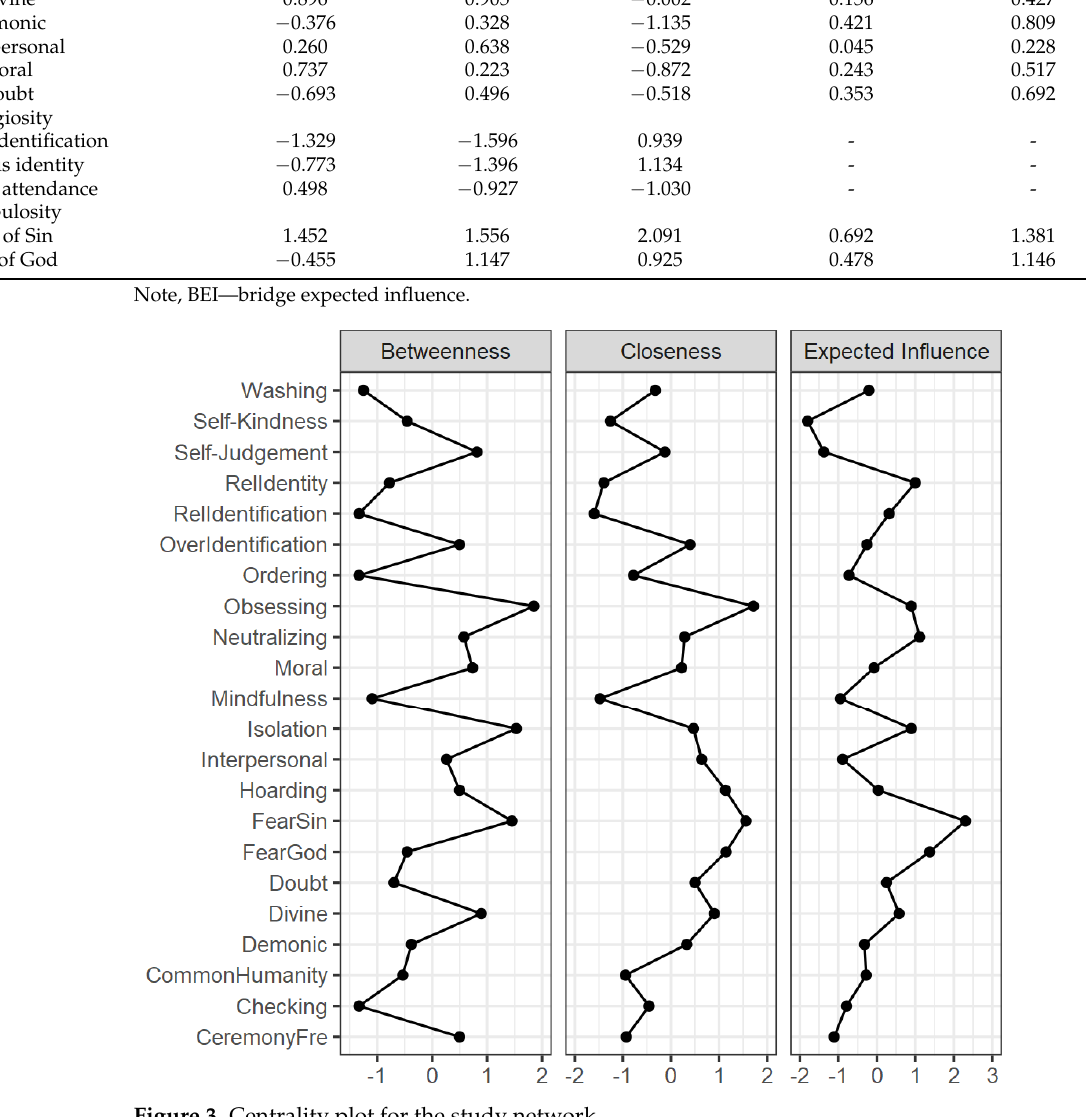
Figure 3. Centrality plot for the study